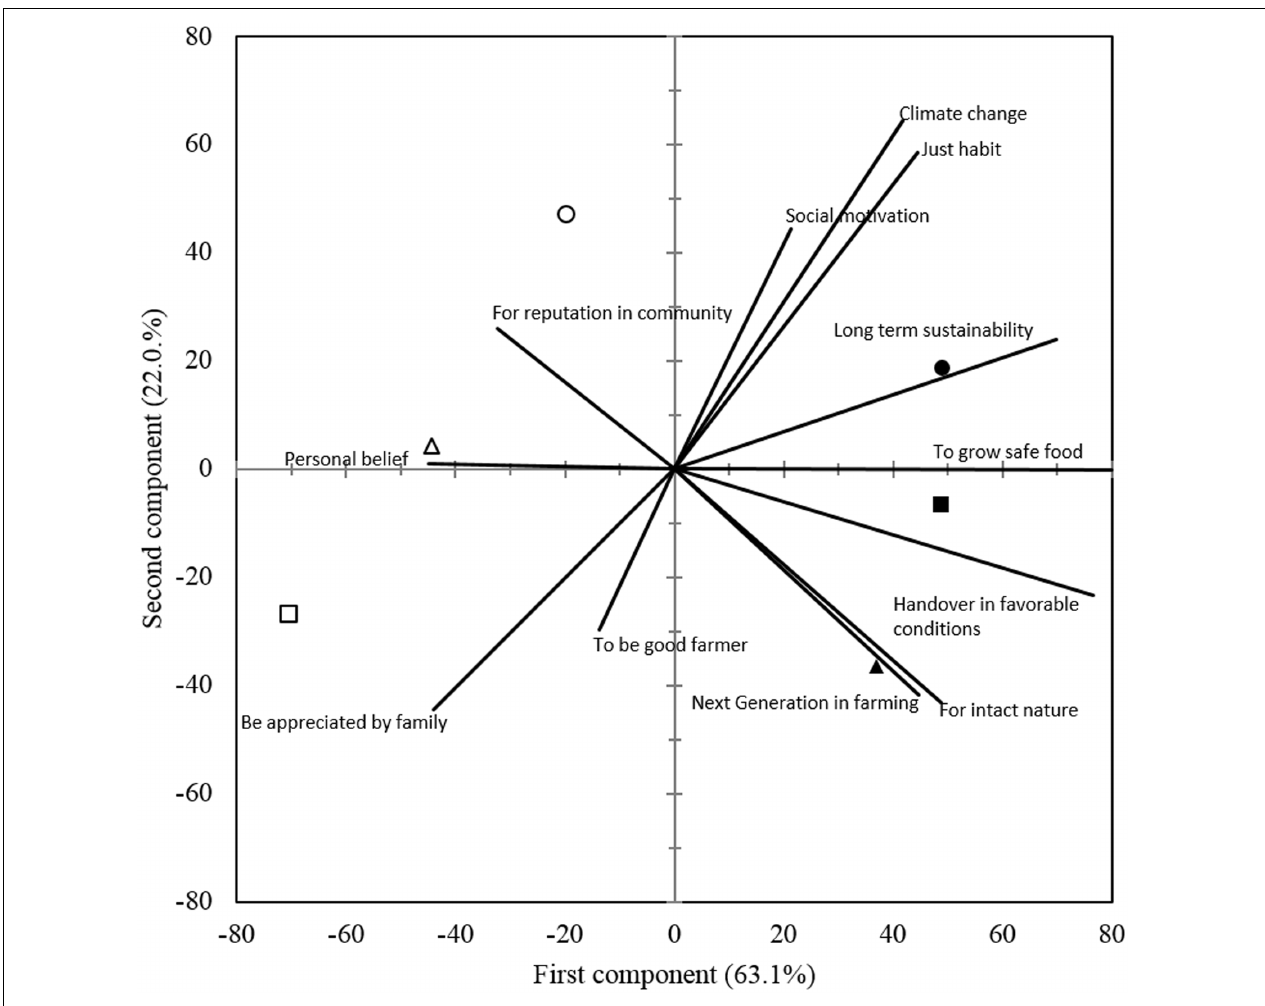
FIGURE 4 | Biplot for the principal component analysis of the respective social motivational characters of